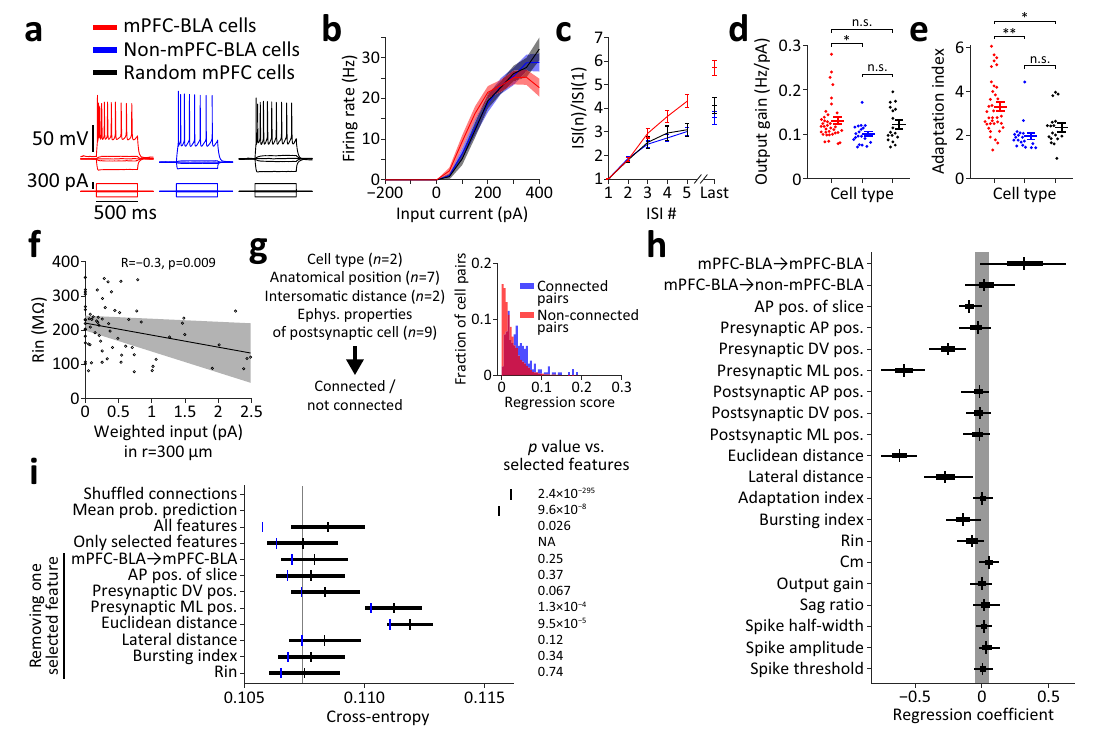
Fig. 4 | Determinants of functional synaptic connectivity among mPFC pyr- amidal neurons. a – e Electrophysiological properties of cell populations in the ventralmPFC( n =36mPFC-BLAcells, n =19non-mPFC-BLAcells,and n =17random cells). a Representative current injection traces recorded from the three cell types corresponding to the connectivity maps in Fig. 3. b Firing rate as function of injectedcurrentforallcelltypes.ShadedareasrepresentSEM. c Ratiobetweenthe n-thandthe fi rstinter-spikeintervals(ISIs).ISIsaretakenfromthecurrentinjection traces evoking closest to 80% of the maximal fi ring rate per cell. In c – e , error bars indicatemean±SEM. d Outputgainforeachcelltype.Kruskal-Wallistestwithpost hoc comparisons, * p = 0.015; n.s. p ≥ 0.26. e Adaptation index for each cell type. Kruskal-Wallis test with post hoc comparisons, ** p = 6.0×10 – 6 ; * p = 0.016; n.s. p = 0.24. See Fig. S8a for additional electrophysiological properties and Table S3 for full statistics. f Correlation between weighted input and input resistance across all cell types. The line indicates a linear fi t and the shaded region represents its 95% con fi dence interval. g Logistic regression model for predicting connectivity using all available features ( n = 20 total features; n for each category is mentioned in parentheses) on all cell pairs in the entire mPFC ( n = 7752 cell pairs). Right, Model score calculated for connected cell pairs and for non-connected cell pairs. h Feature selection performed using Horseshoe priors on the regression model, usingthesamecellpairsasin g .Foreachcoef fi cient,themedian(verticalline),25th and 75th percentiles (box), and 90% highest density interval (HDI, whiskers) of the